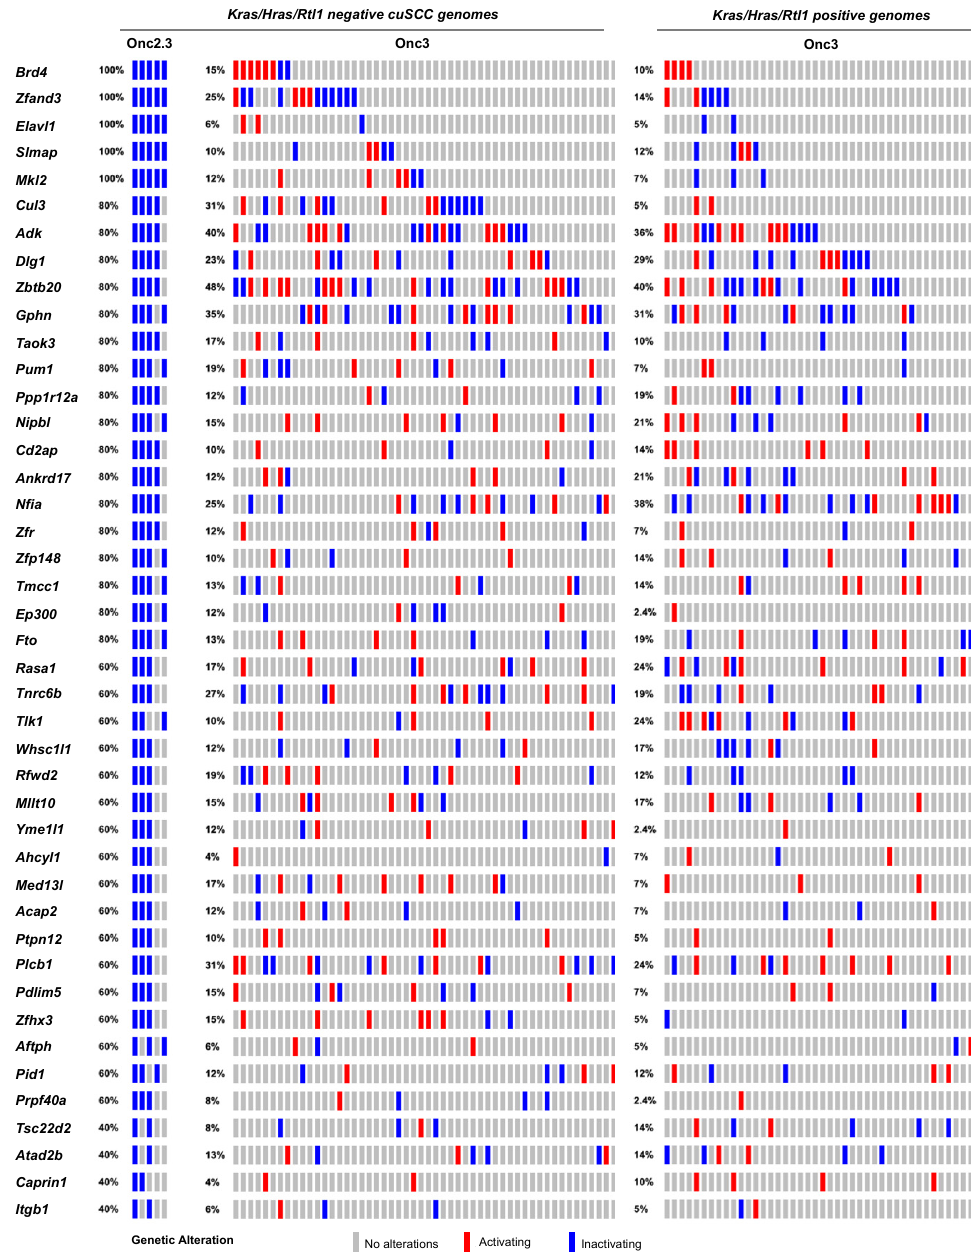
Figure 4. SB-driven liver cancer by cumulative tumor suppression. Recurrent inactivating SB insertions in Onc2.3 (n = 6 using SBCapSeq) and Onc3 (n = 52 Kras / Hras / Rtl1 oncogene negative using 454T sequencing; n = 42 Kras / Hras / Rtl1 oncogene positive using 454T sequencing) induced HCA genomes.